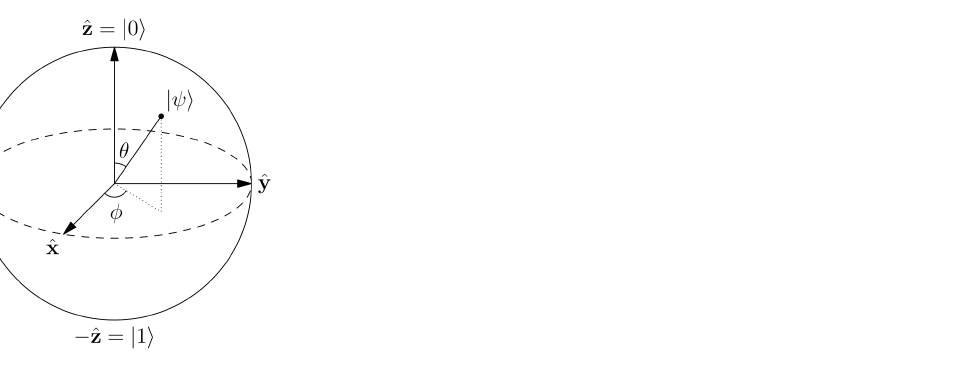
Figure 2. A representation of the Bloch sphere. The image [27] has license Creative Commons Attribution- Share Alike 3.0 Unported